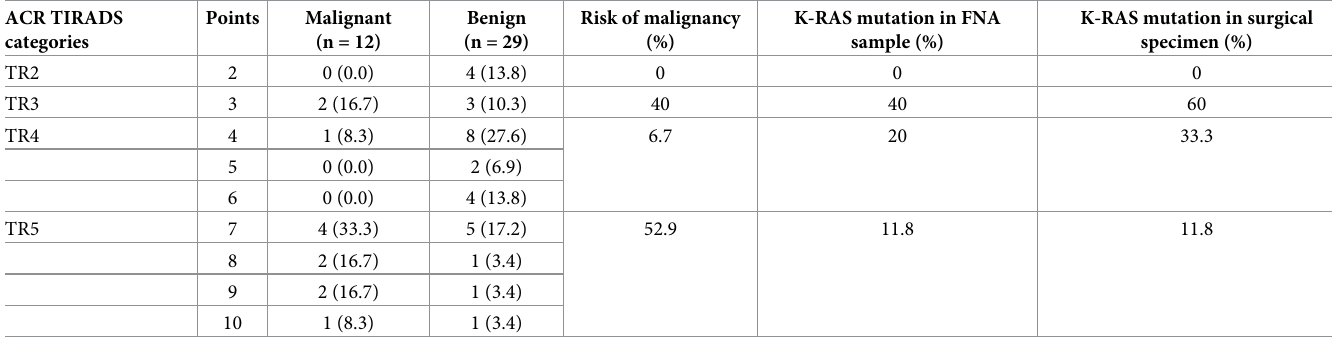
Table 2. ACR TIRADS categories of cytological indeterminate thyroid